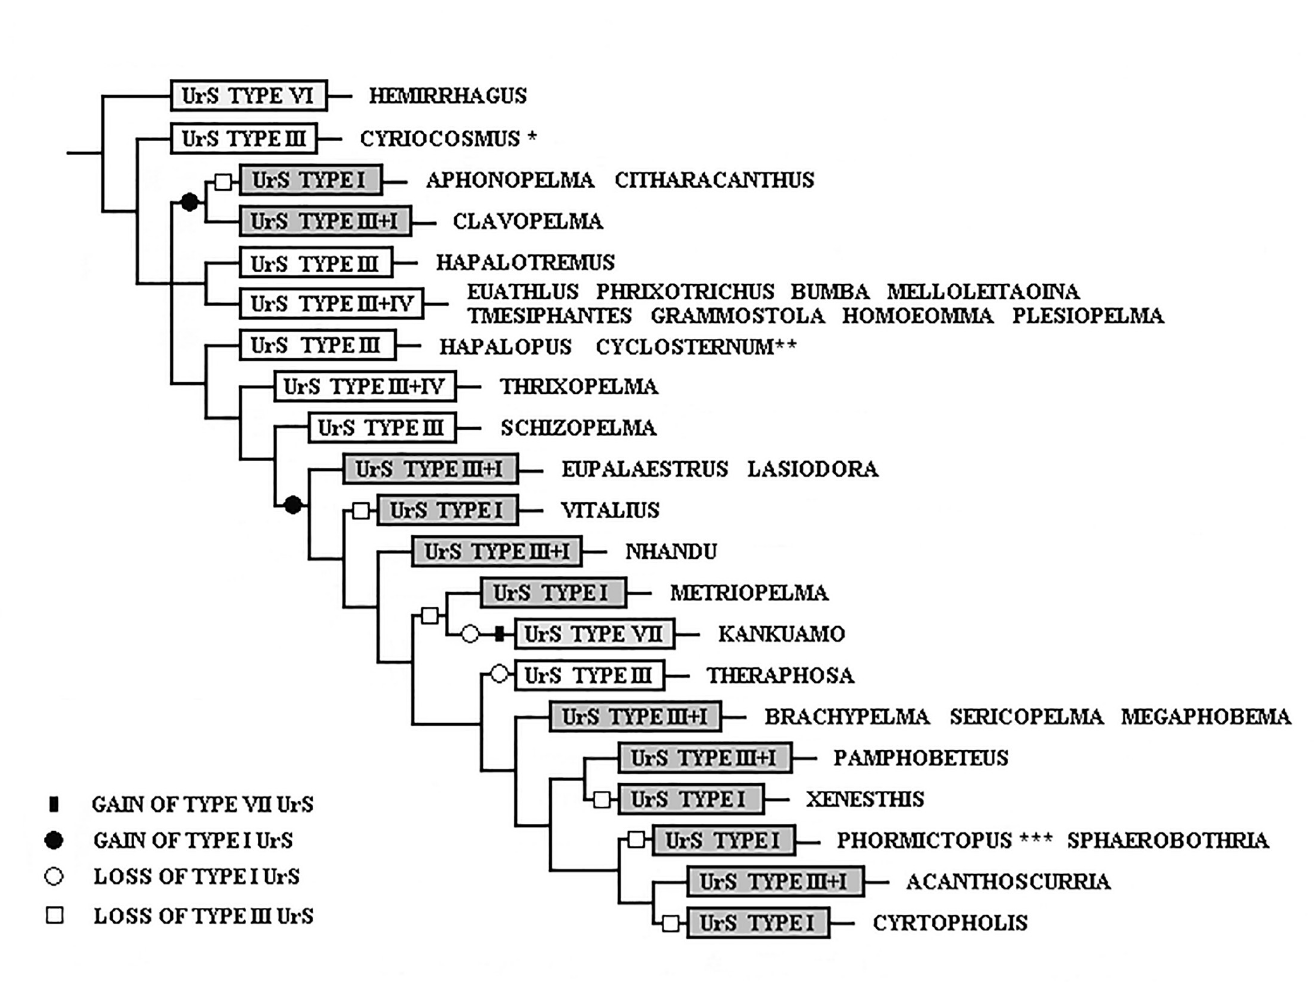
Fig 18. Hypothesis of urticating setae evolution based on the modified cladogram by Perafa´n et al. [11]. Remarks: � In the data matrix, Cyriocosmus is mentioned without any type of urticating setae instead of the presence of type III setae. This could explain its basal position in the cladogram. �� Female syntype of Cyclosternum schmardae as generic type possesses type I setae. ��� Phormictopus possesses urticating setae of types I and III.